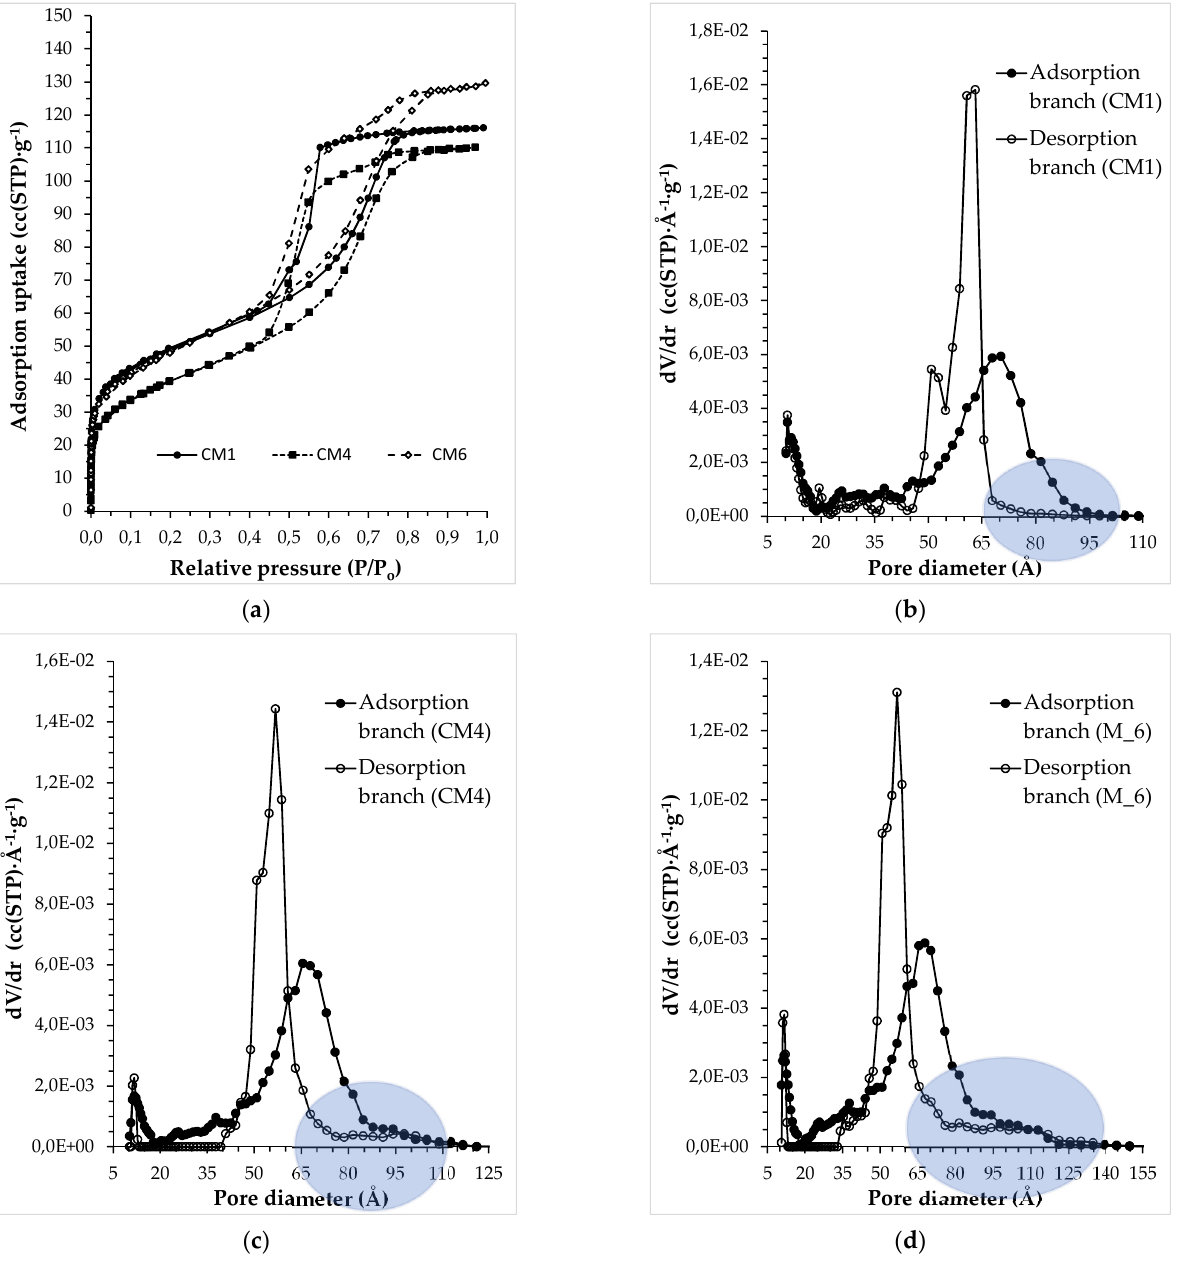
Figure 10. ( a ) N 2 adsorption isotherms (at 77 K) for the CM1, CM4, and CM6 membranes and the PSD curves from the adsorption and desorption branch for ( b ) CM1, ( c ) CM4, and ( d ) CM6 of the respective adsorption isotherms, by NLDFT analysis for cylindrical silica pores.